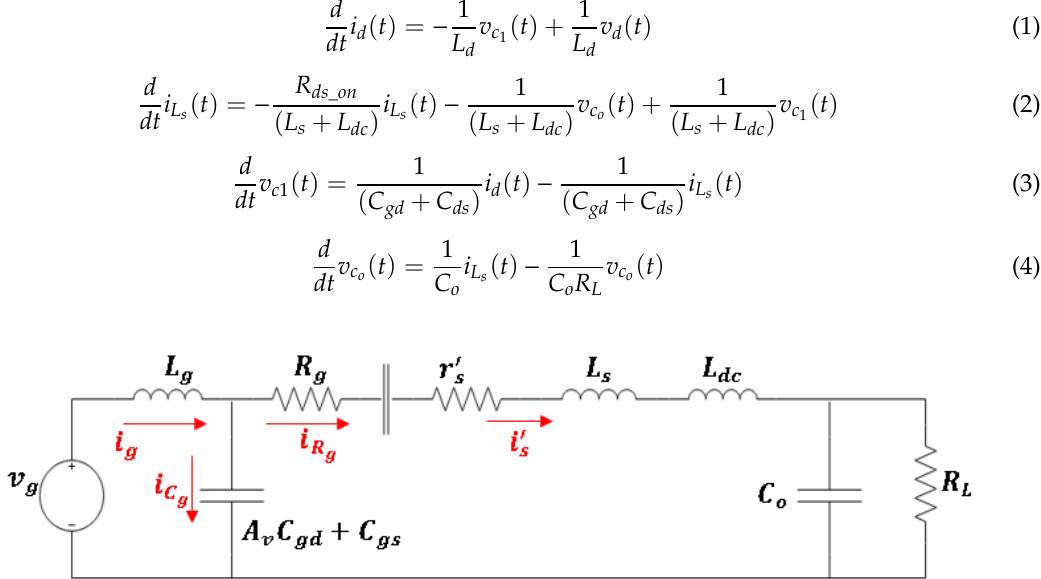
Figure 6. Modeling the gate-source circuit in the GaN FET system.